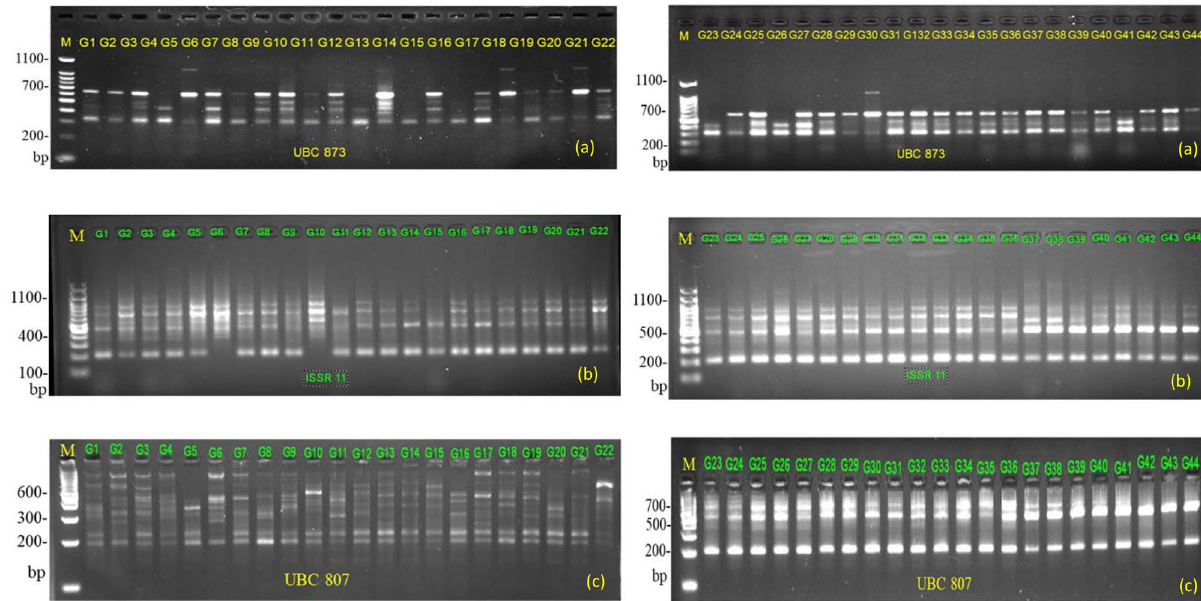
Figure 1. Inter simple sequence (ISSR) banding profiles of 44 V . subterranea accessions. The PCR product of (a) the UBC 873 primer; (b) ISSR 11 primer, and (c) UBC 807 amplified with Agarose gel electrophoresis using IMAGE Lab ver. 5.0 program (BIO-RAD). In each gel, we run 22 accessions at a time and lane M refers to 100 bp DNA ladder, and lane with a numeric number refers to the accession number listed in Table 1. The full- length blots/gels are presented in supplementary Fig. S1